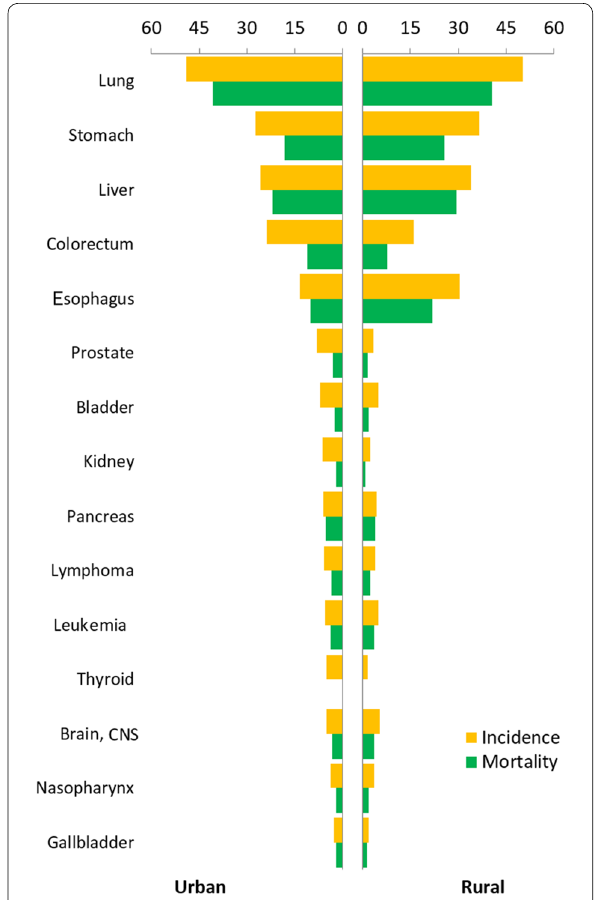
Fig. 1 Cancer incidence and mortality in urban and rural areas for males in China in 2012 (1/100,000). CNS central nervous system